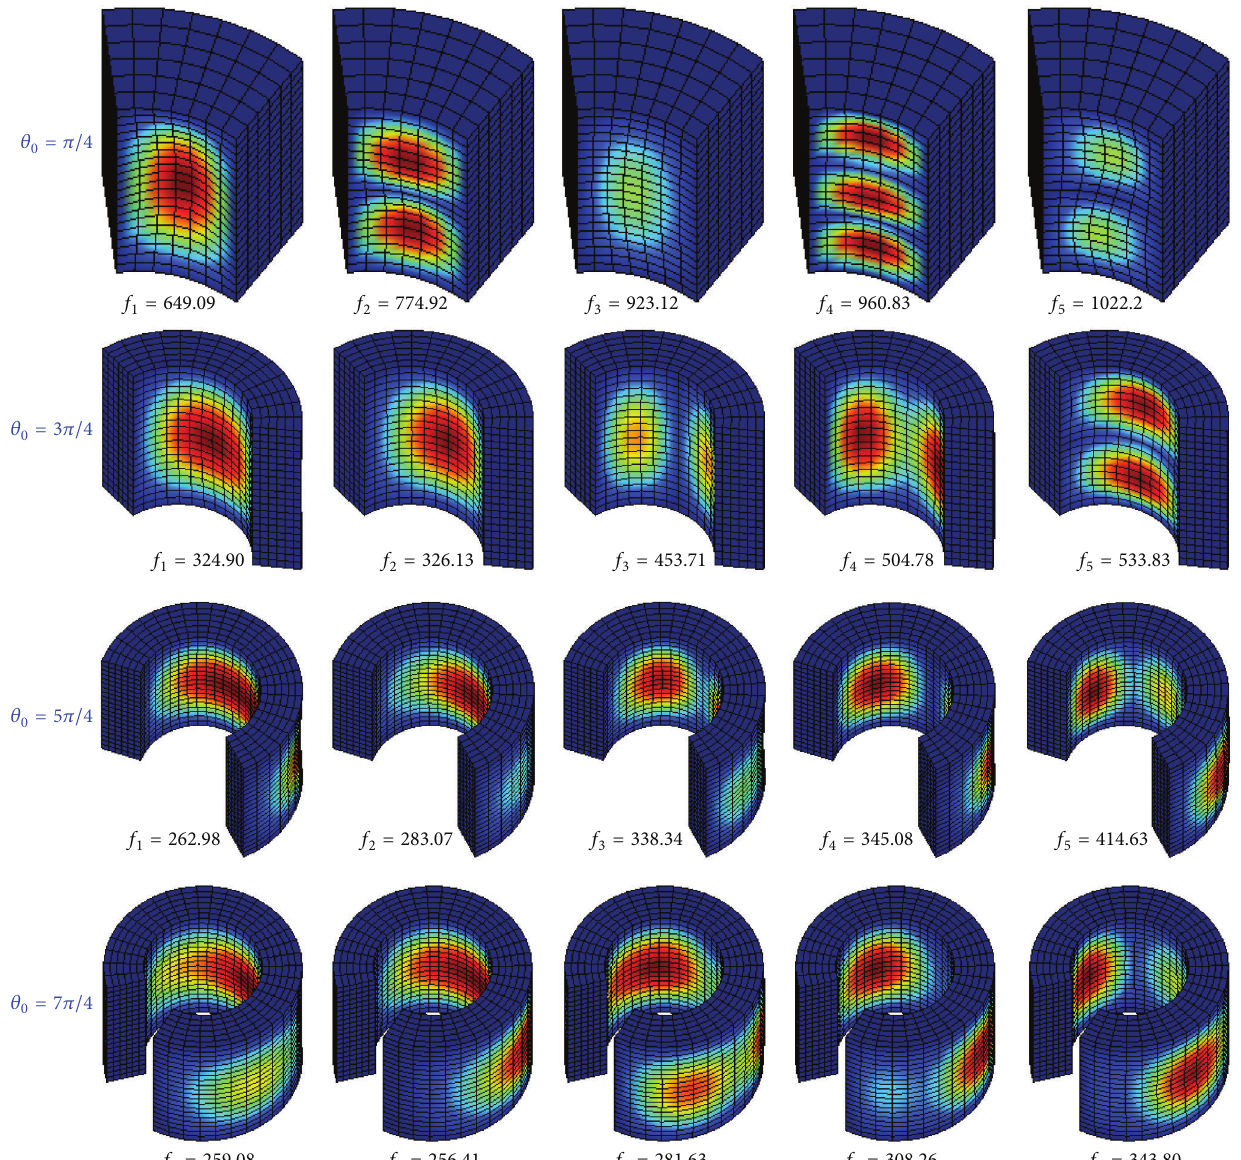
Figure 5: Mode shapes of an orthotropic cylindrical shell with CCCC boundary conditions and various circumferential